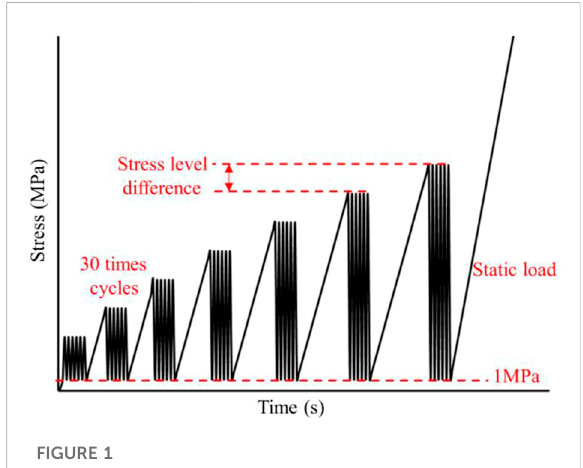
FIGURE 1 Schematic diagram of low-cycle multi-period cyclic loading stress